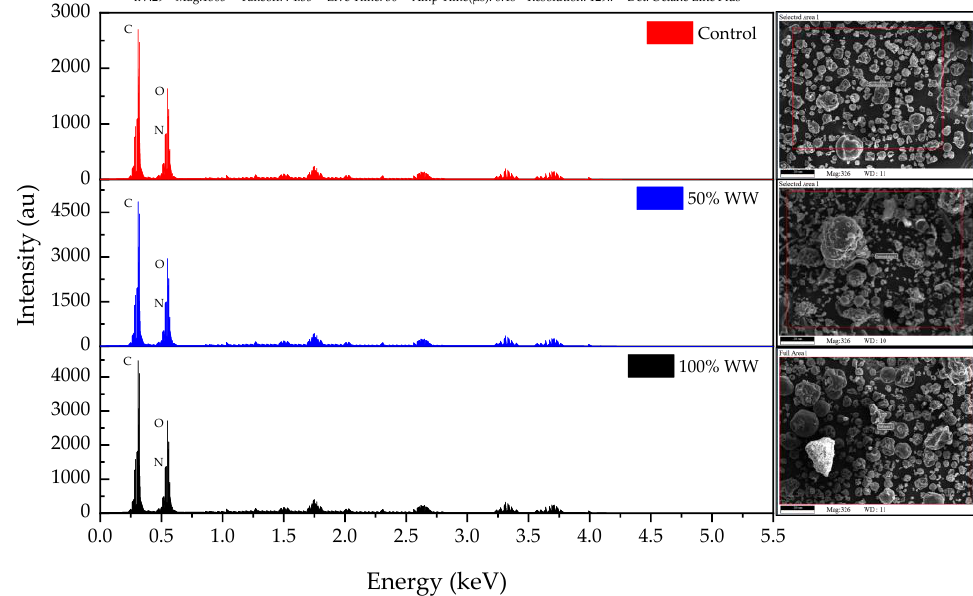
Figure 5. EDX graphs for ultimate element analysis (C, O and N) of C. vulgaris biomass cultivated in different concentrations of mushroom farm wastewater (WW: wastewater).